Question: Write a descriptive caption for this figure.
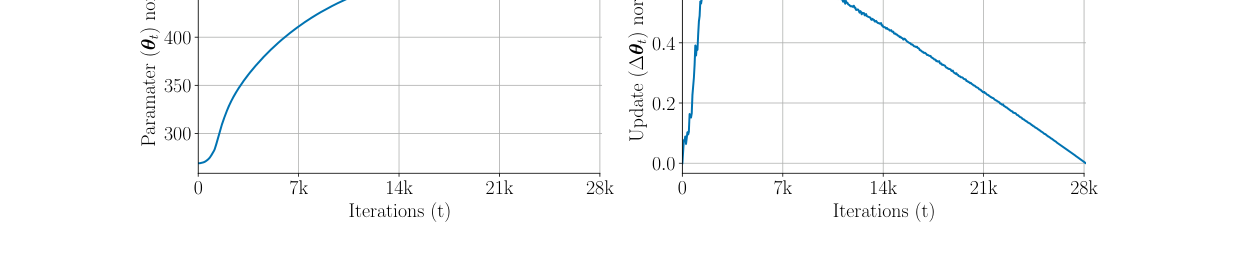
Answer: Bert-base-uncased phase-1 pretraining with settings as described in Section 5.1. Left: Model parameter L2 norm vs iterations for BF16 and FP32 master weights strategy. Right: update ∆θt L2 norm across iterations. The model parameter norm and update norm are at different scales, for example, ∼450 vs ∼0.5 at 14k iterations, which is a factor of 900 and causes lost arithmetic.